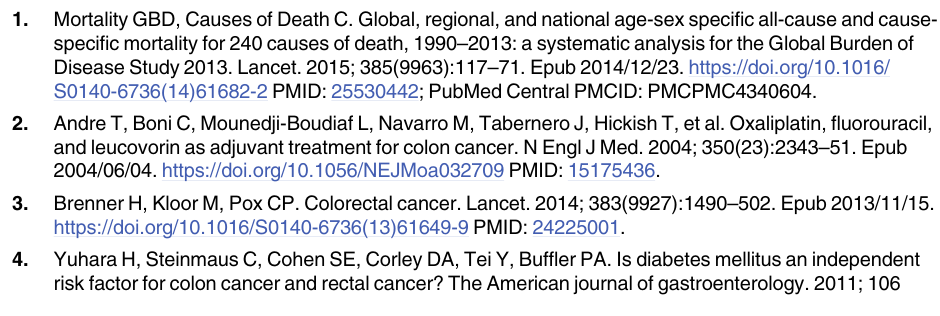
S1 Table. The metformin signature. The gene signature extracted from metformin-treated LoVo cells. S2 Table. IPA anlaysis for canonical pathway. S3 Table. The gene set enrichment analysis result. S4 Table. The demographics of colon cancer patients. S1 File. The tables for statistics